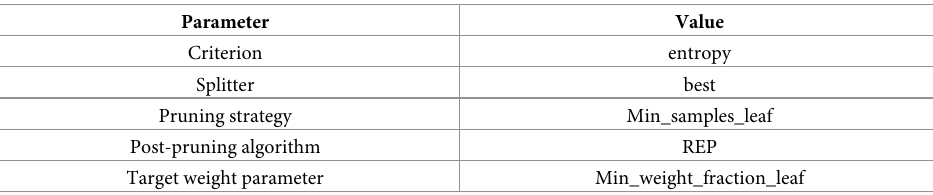
Table 1. Parameter setting of the C4.5